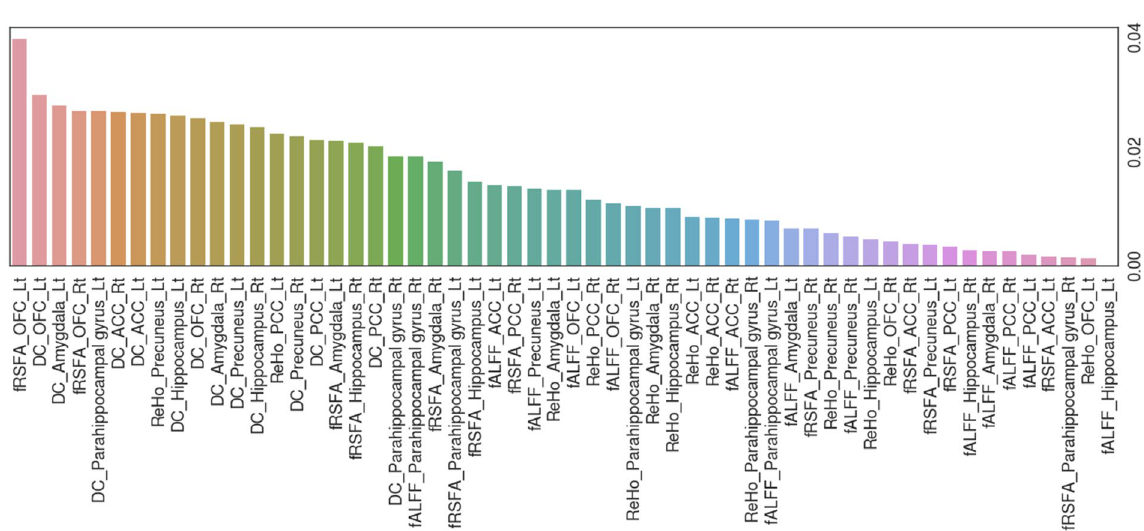
Figure 4. Feature importance bar plot all input resting-state brain functional radiomic features. The importance value is estimated by SHapley Additive exPlanation (SHAP) feature importance method on the eXtreme Gradient Boosting (XGBoost) model with the test data split. Rt right, Lt left, DC degree centrality, fRSFA fractional resting-state physiological fluctuation amplitude, fALFF fractional amplitude of low-frequency fluctuation, ReHo regional homogeneity, PCC posterior cingulate cortex, OFC orbitofrontal cortex, ACC anterior cingulate